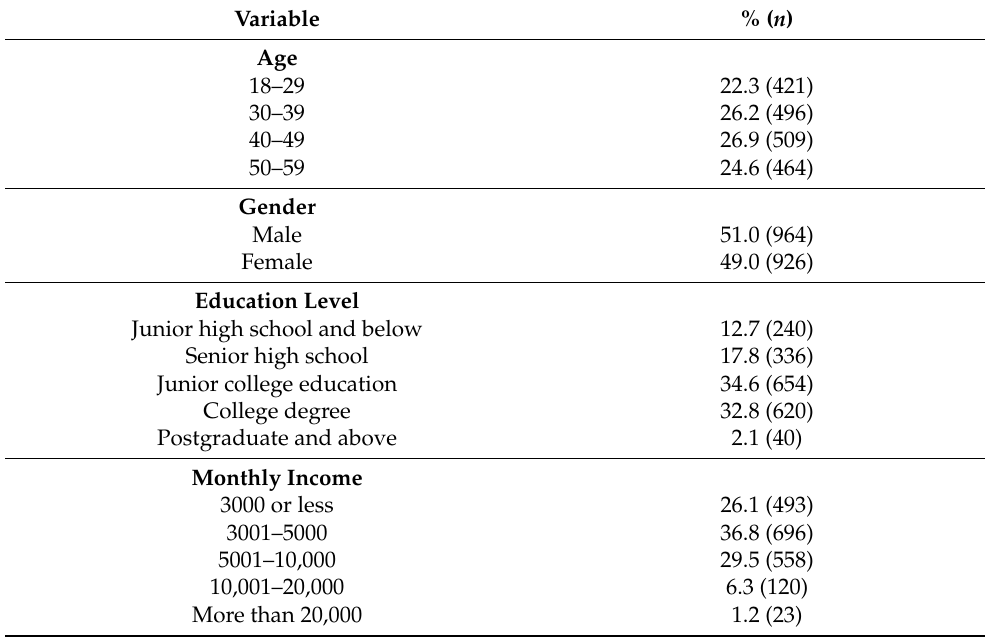
Table 1. Distribution of demographic characteristics of the sample ( n =